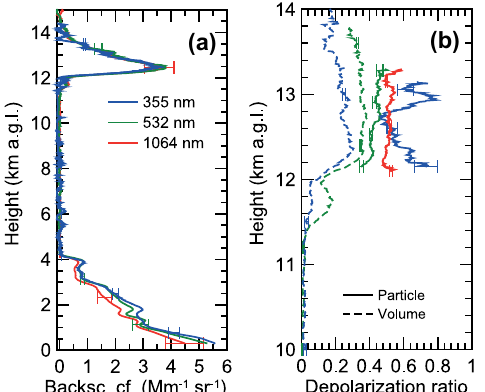
Figure 6. (a) Aerosol layers below 4km height and cirrus layer from 12 to 14km height in terms of particle backscatter coefficient at three wavelengths observed with BERTHA on 20–21 June 2014, 23:10-02:10UTC (signal averaging period), and (b) cirrus ice crys- tal depolarization ratio (solid lines, volume depolarization ratio as dashed lines) at three wavelengths. At 1064nm the volume depolar- ization ratio is equal to the particle depolarization ratio. The vertical signal smoothing length is 200m. Error bars show the relative un- certainty in the retrievals (1 standard